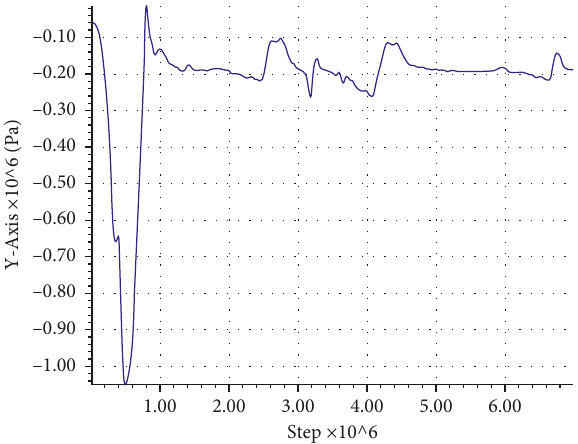
Figure 10: The time-course curve of the Earth pressure at anti-slide pile No. 1.